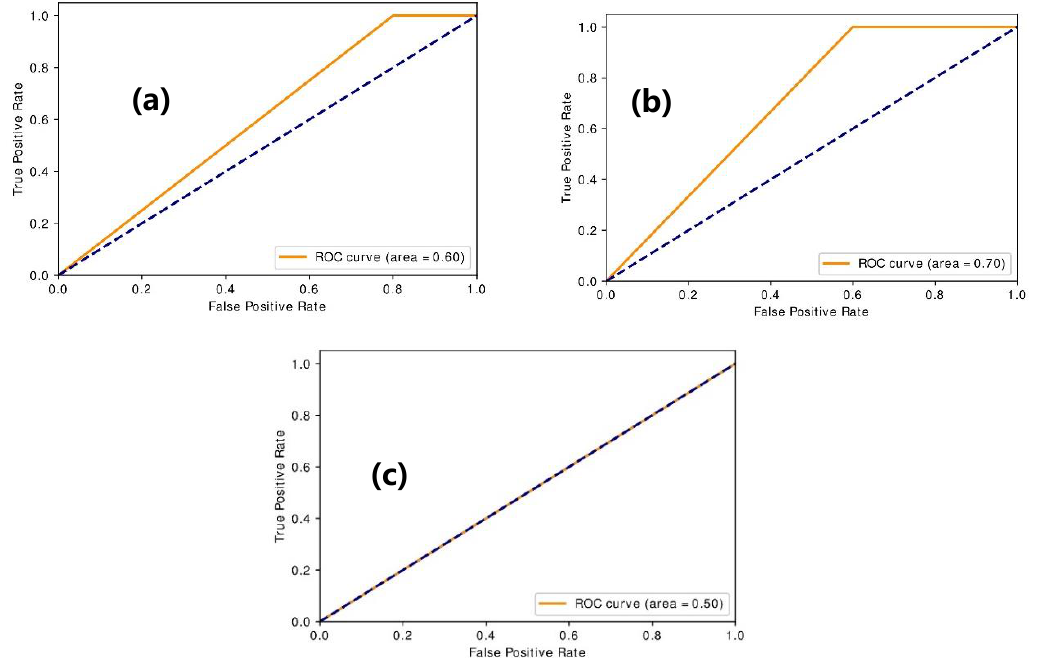
Figure 11. The ROC curves of: ( a ) logistic regression, ( b ) Random Forest, and ( c ) SVM. ROC, receiver operating characteristic; SVM, support vector machine.